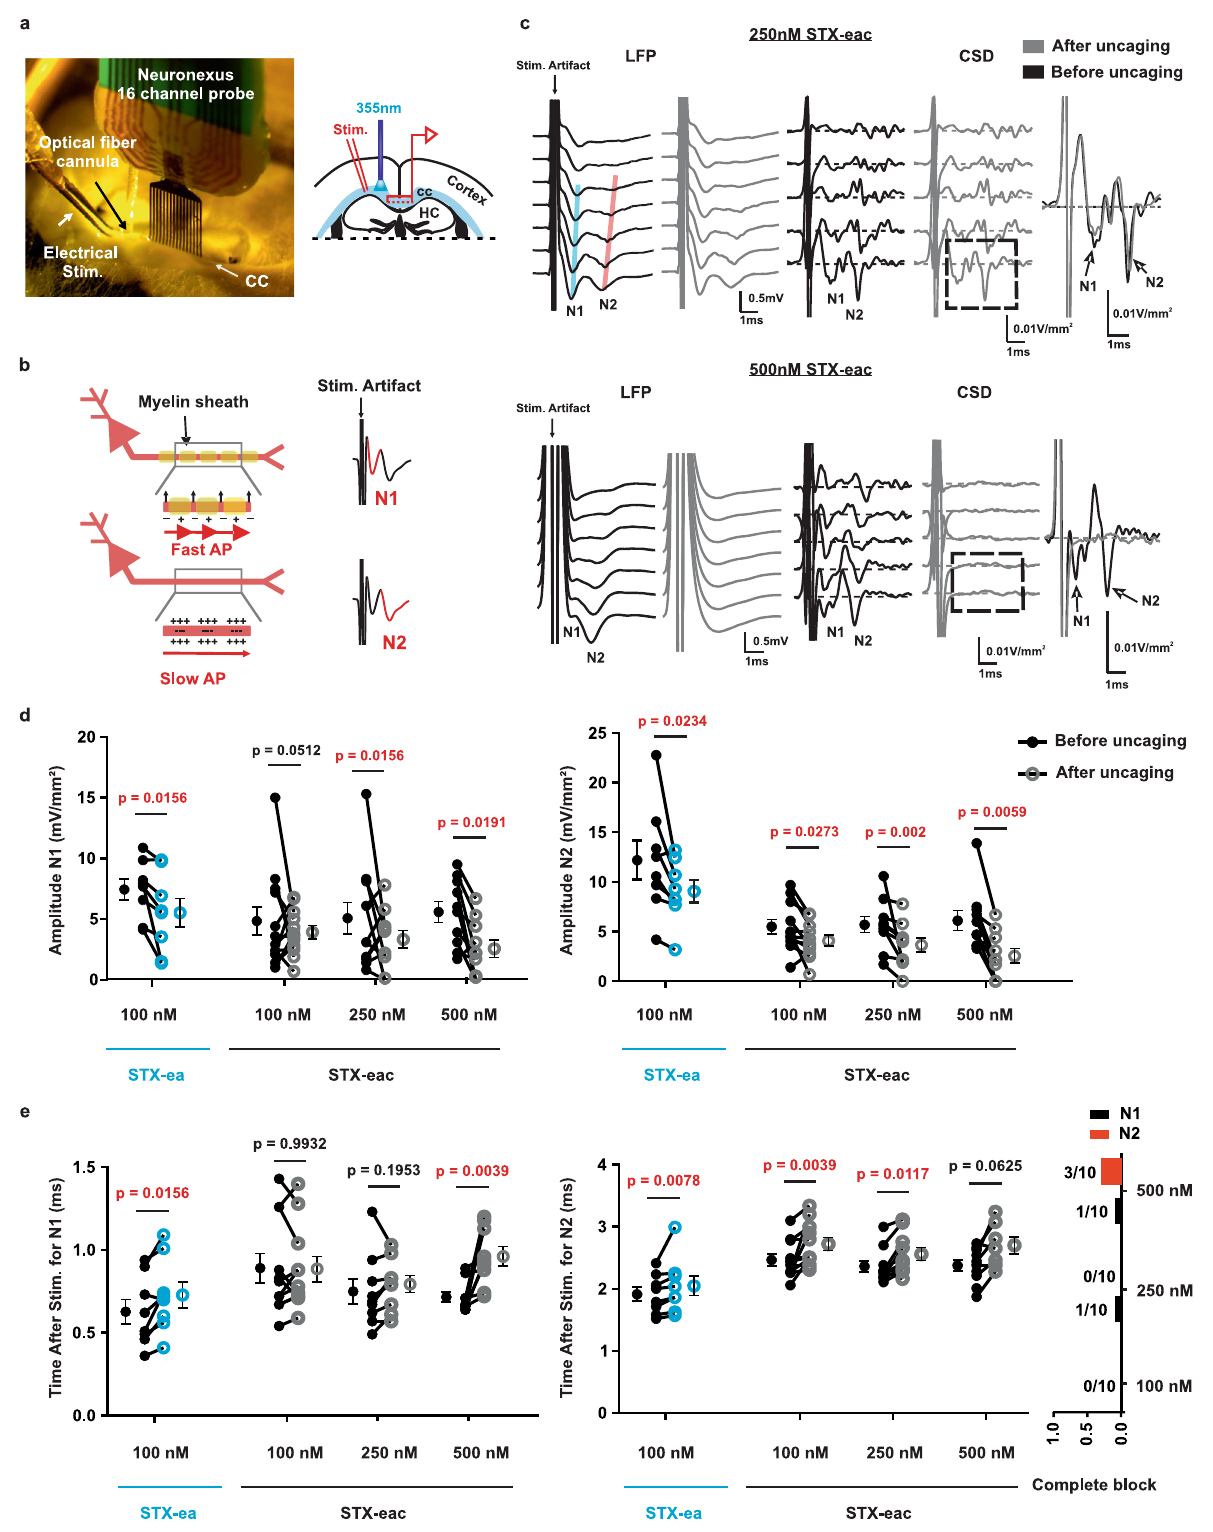
the integration of 1 H signals corresponding to the toxin and a fi xed concentration of the DMF standard. Compounds . Coumarins 6-bromo-4-(hydroxymethyl)-7-methoxycoumarin ( 6 ), 6- bromo-7-hydroxy-4-(hydroxymethyl)coumarin ( 7 ), and 7-[bis(tert-butox- Synthesis of N21-saxitoxin ethylamine ( 1 ) was adapted from our